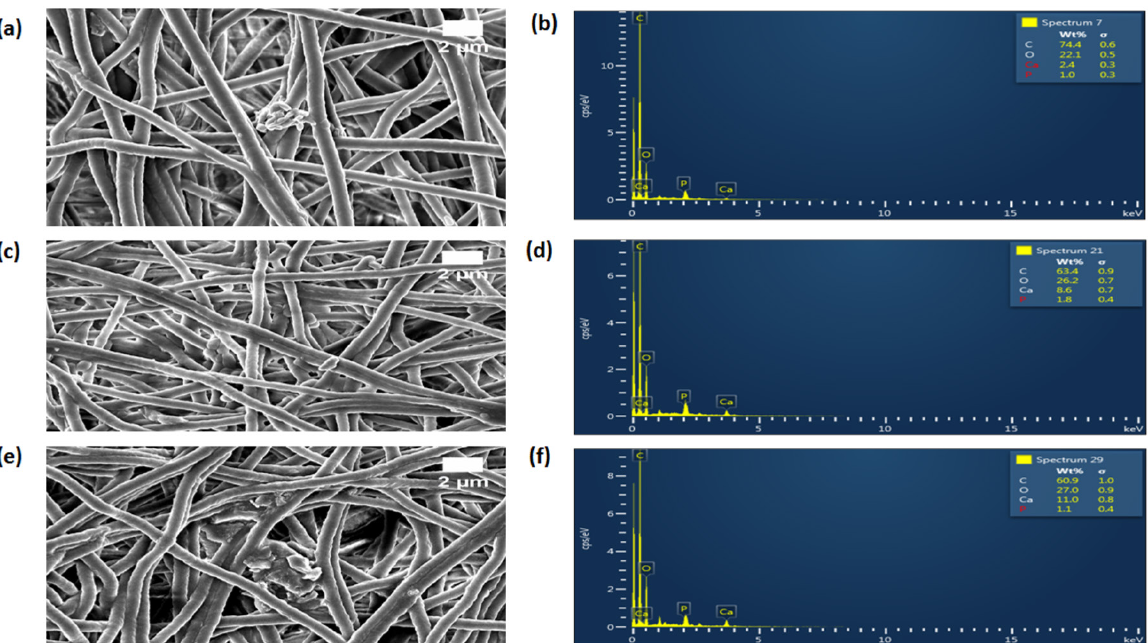
Figure 8. Bone mineralization testing a,c,e) FESEM images of electrospun membranes and b,d,f) EDX spectrum of electrospun